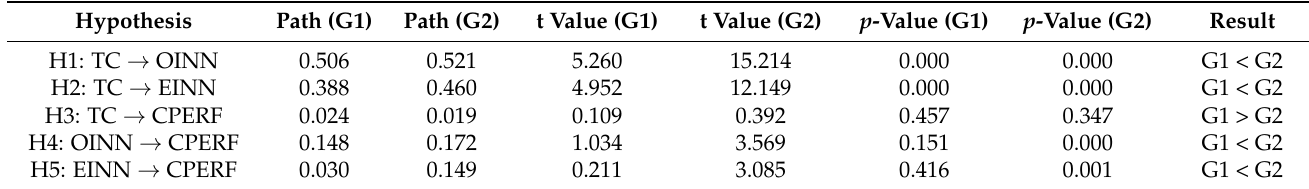
Table 10. Hypothesis (Multigroup Analysis) .